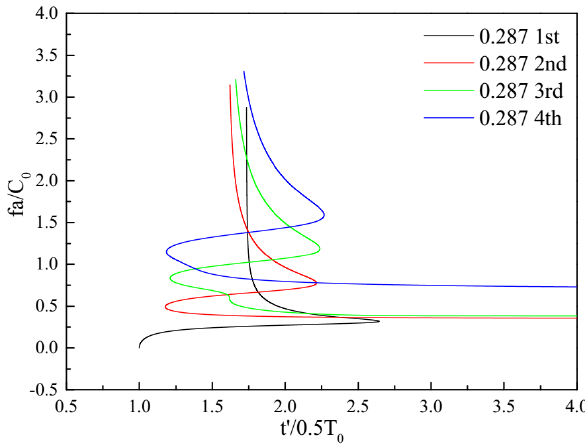
Figure 5. The first to fourth normal frequency and propagation time curves of Poisson ’ s ratio of 0.287.